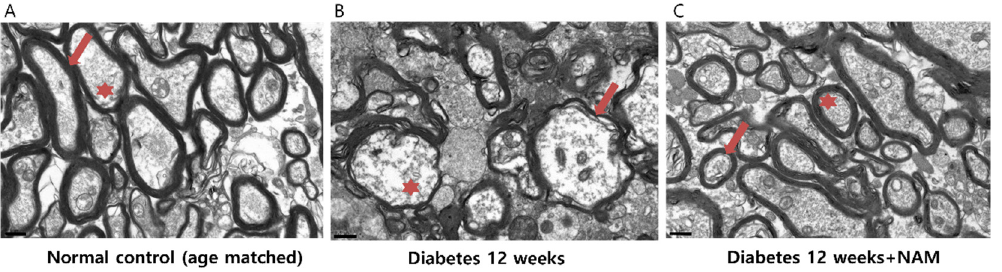
Figure 9. Electron microscopy of cross-sections through the region surrounding the distal myelinated optic nerve demonstrated that axons with normal axoplasm were surrounded by myelin sheaths in the normal control eyes ( A ). In the diabetic retinas, myelin sheaths were thinned and unorganized, and axoplasm was sparse compared to the control retinas ( B ). In the retinas of diabetes model mice that underwent nicotinamide treatment, myelin sheaths and axoplasm were relatively preserved ( C ). Scale bars = 0.5 µm. NAM, nicotinamide. Red asterisk, axoplasm. Red arrow, myelin sheaths.